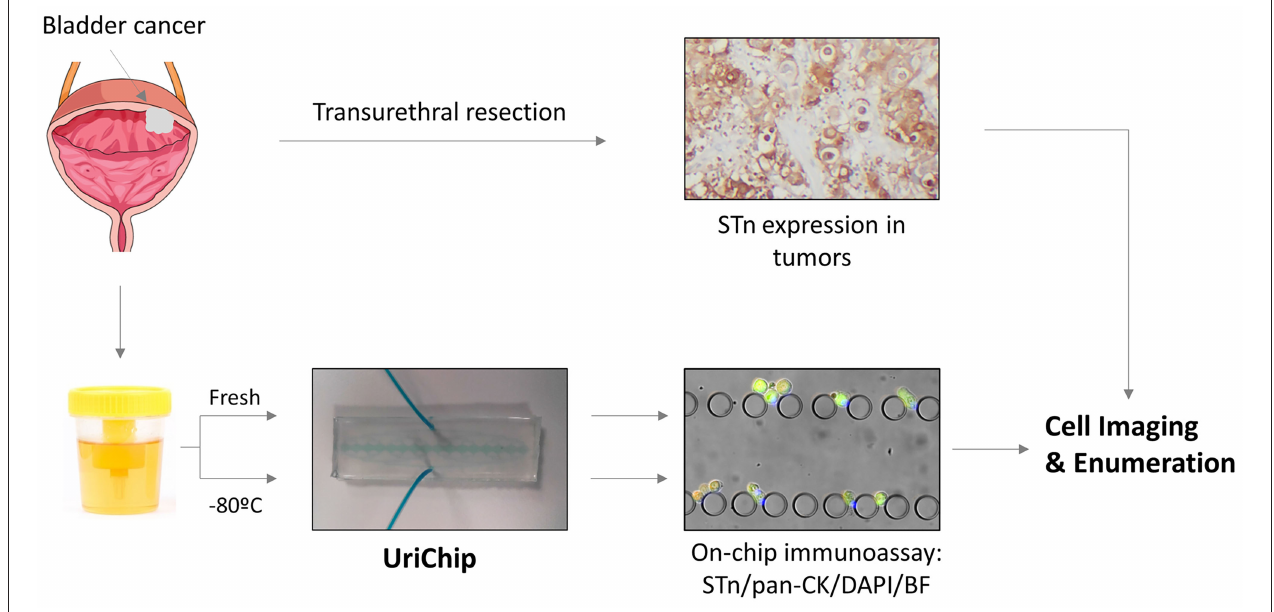
FIGURE 1 | Schematic representation of the enrichment and analysis of urothelial exfoliated cells from bladder washes and voided urine of BC patients using the UriChip. Bladder washes and voided urine from BC patients were collected, subjected or not to cryopreservation and run into the UriChip. A dual biomarker immunoassay was then performed, comprising pan-CK (epithelial marker), STn (tumor associated marker), and DAPI (nuclei staining). Trapped cells were next imaged by immunofluorescence microscopy and nucleated cells expressing STn and/or CK counted. In parallel, corresponding FFPE tissues were screened for STn by immunohistochemistry and results compared to clinicopathological information of